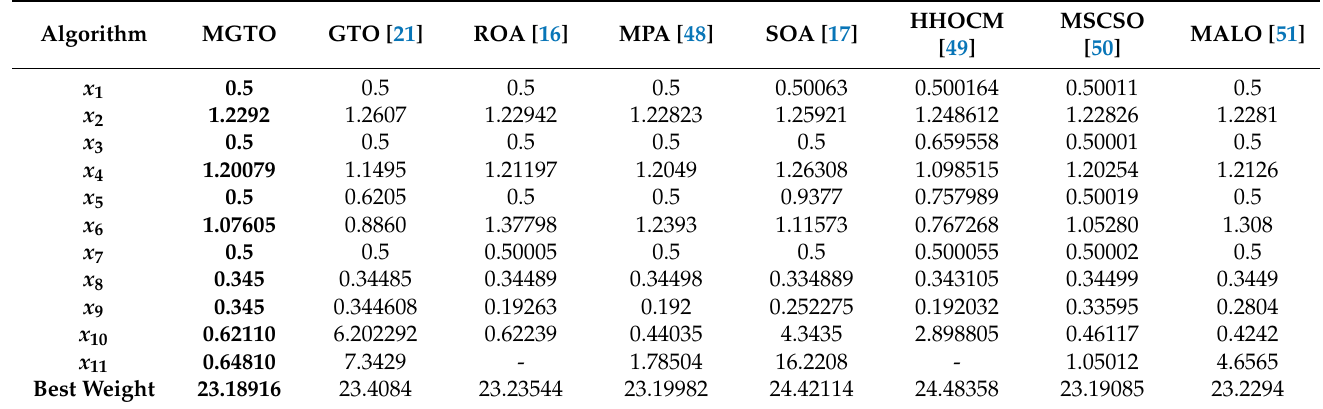
Table 15. Experimental results of the car crashworthiness design problem